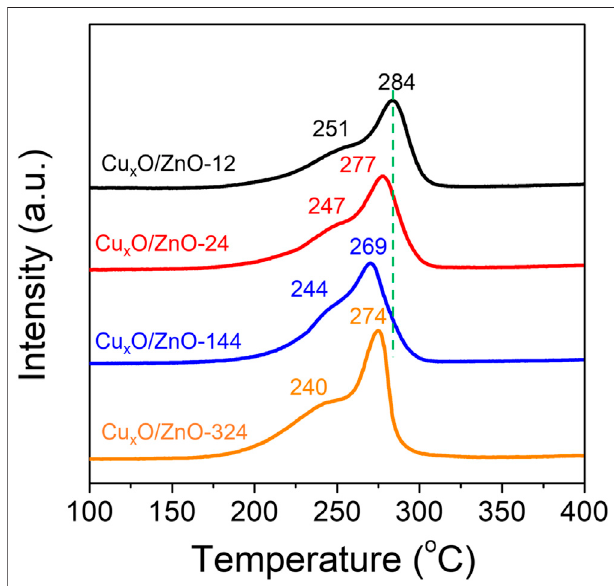
FIGURE 2 | H 2 Temperature-programmed reduction pro as-synthesized Cu x O/ZnO catalysts.